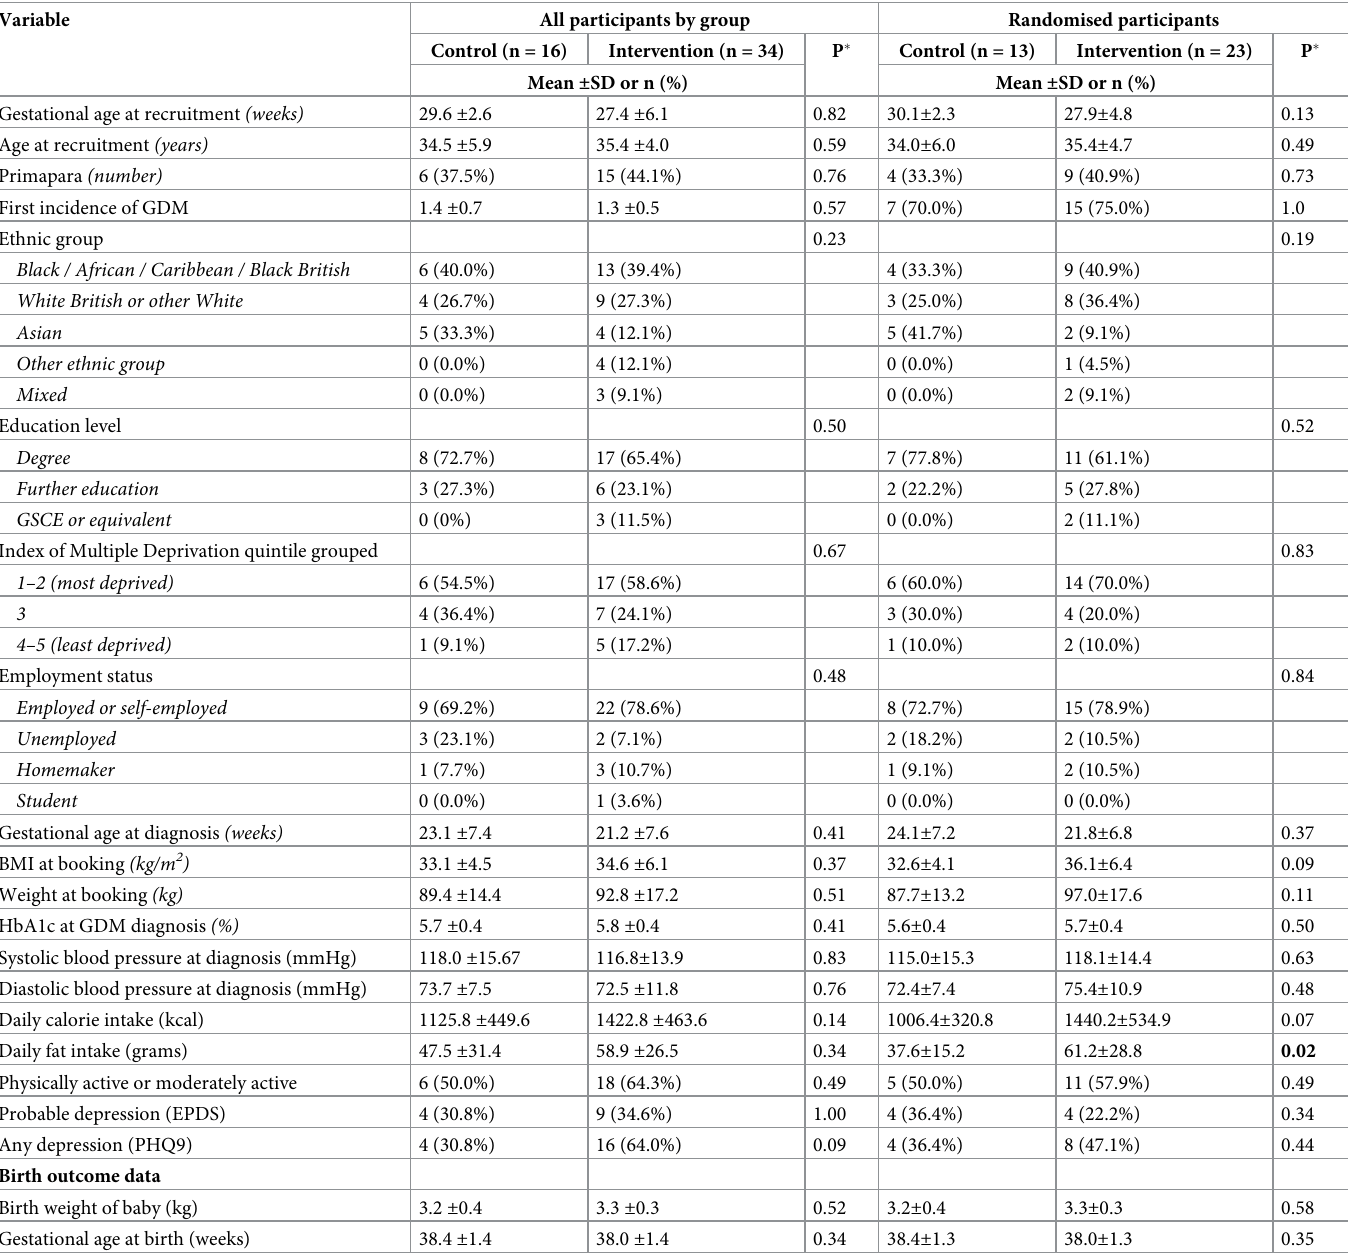
Table 1. Baseline and birth outcome data by group: All participants and randomised participants. Variable All participants by group Randomised